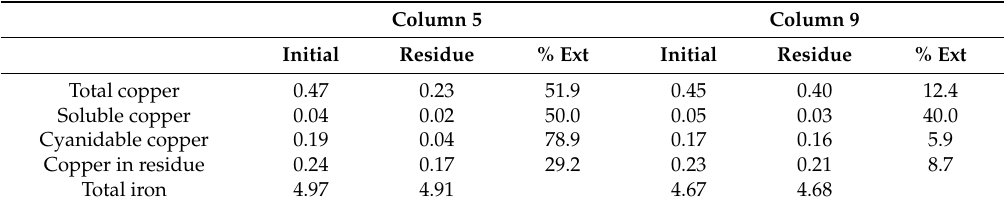
Table 11. Copper extractions in column 5 (32.9 ◦ C, 0.6 kg H 2 SO 4 /50 kg of ore, 0.525 kg NaCl/50 kg of ore, 0.5 kg FeSO 4 /50 kg of ore) and column 9 (14.5 ◦ C, 0.6 kg H 2 SO 4 /50 kg of ore, 0.525 kg NaCl/50 kg of ore, 0.5 kg FeSO 4 /50 kg of